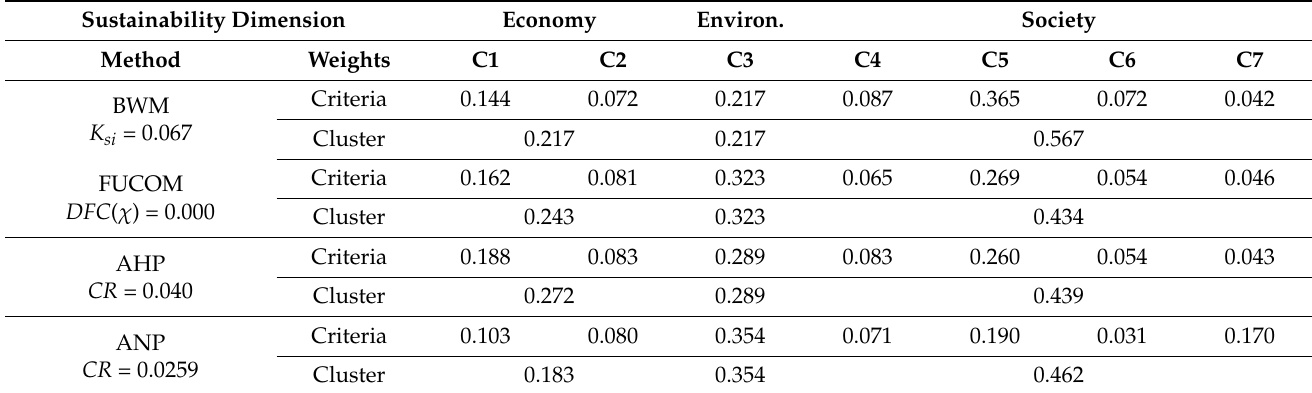
Table 13. Criteria subjective weighting using BWM, FUCOM, AHP, and ANP methods.